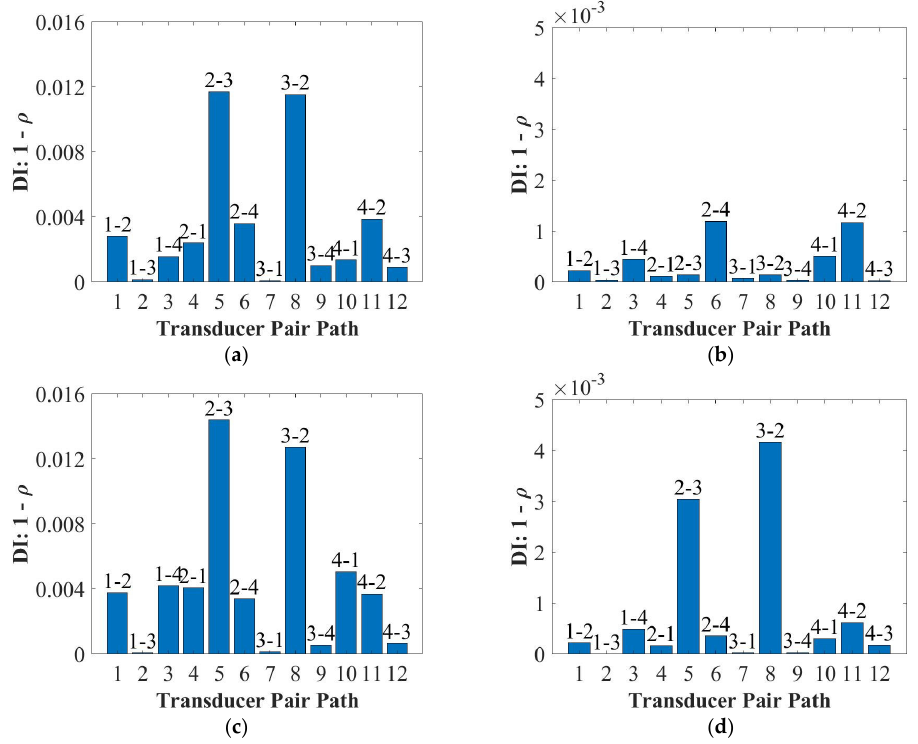
Figure 11. Damage detections for the 9 mm thick panel at 50 kHz ( a ) and 250 kHz ( b ) for the opposite side of the Blu Tack and at 50 kHz ( c ) and 250 kHz ( d ) for the same side of the Blu Tack.